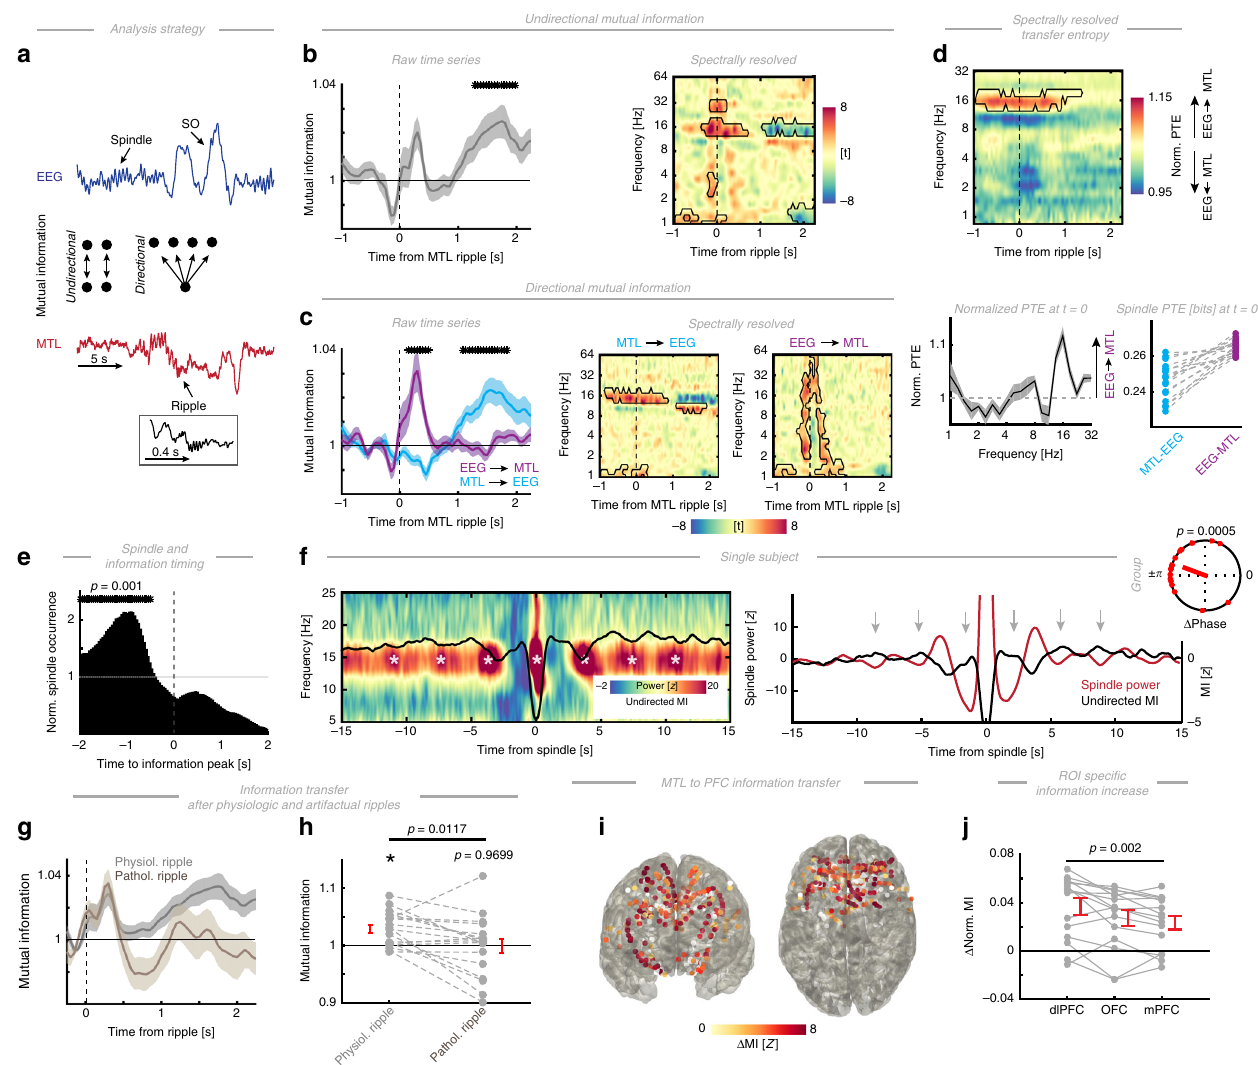
electrodes were used for connectivity analyses (Supplementary Fig. 5a, b). These state-dependent phase synchrony pro fi les exhibited a pronounced 1/f drop-off and the